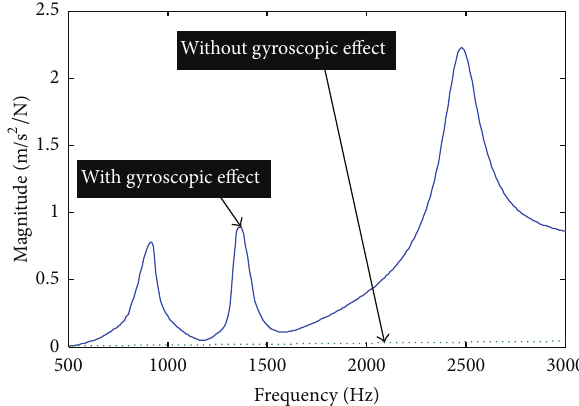
Figure 16: Gyroscopic moment effect of shaft on cross FRF H 𝑦𝑧 at front tip. Rotational velocity: 10000 rpm. Damping ratio: 5%.